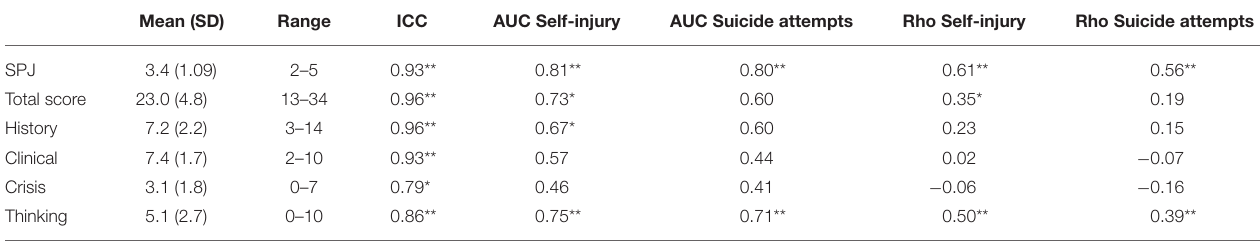
TABLE 4 | Descriptive and inferential statistics for the RoSP in study 2.